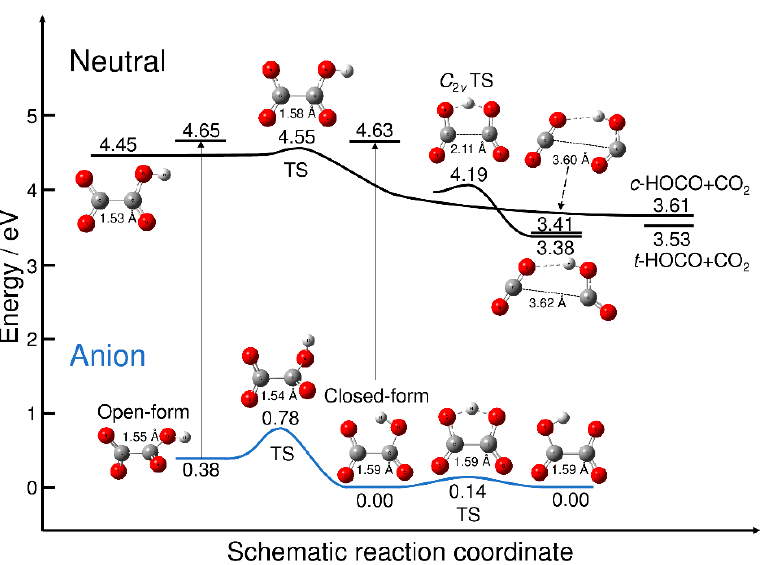
Figure 1. Schematic potential energy surfaces for C 2 O 4 H − and C 2 O 4 H. Energy values were obtained at the B3LYP/aug-cc-pVDZ (with GD3 dispersion correction) level of theory. The energy was measured from the energy level of the most stable isomer of closed-form C 2 O 4 H − . The vertical thin lines with arrows indicate the vertical electron detachment process, and the corresponding energy values are the neutral energy levels at the anion minima. TS: transition state.